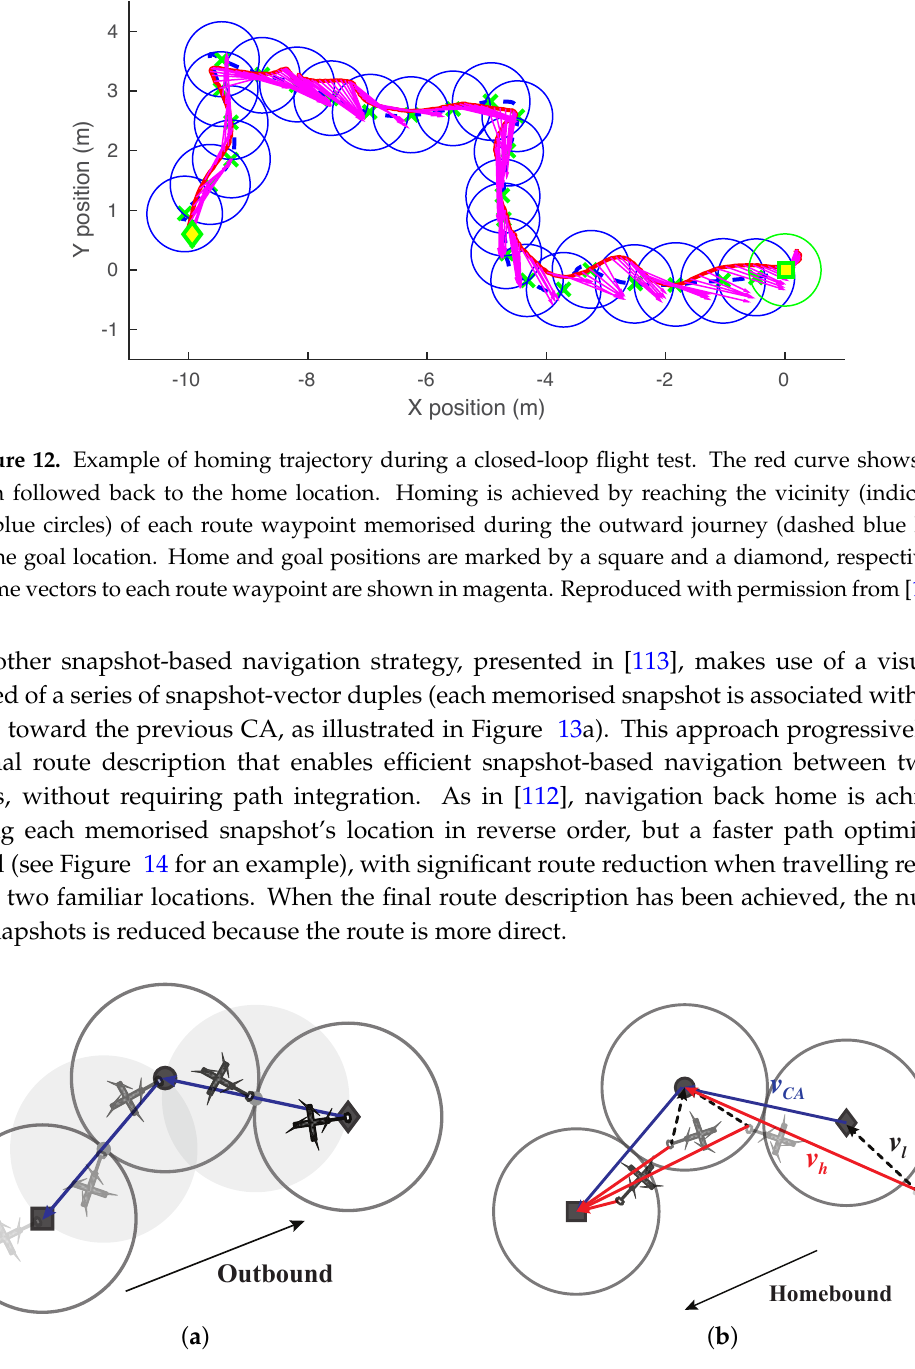
Figure 13. Route learning ( a ) and route following ( b ) using snapshot-vector duples. The solid grey circles represent the catchment areas and the shaded circles are the intermediate catchment areas whose snapshots are only momentarily memorised during route learning. The solid round dots depict the locations of the various snapshots, and the home and goal locations are denoted by the square and diamond respectively. The associated vectors stored with the memorised snapshots are displayed in dark blue. Finally, the dashed vectors are the relative position estimates to the snapshot waypoint locations, as provided by the snapshot-based egomotion estimator [94], and the red arrows represent the local homing